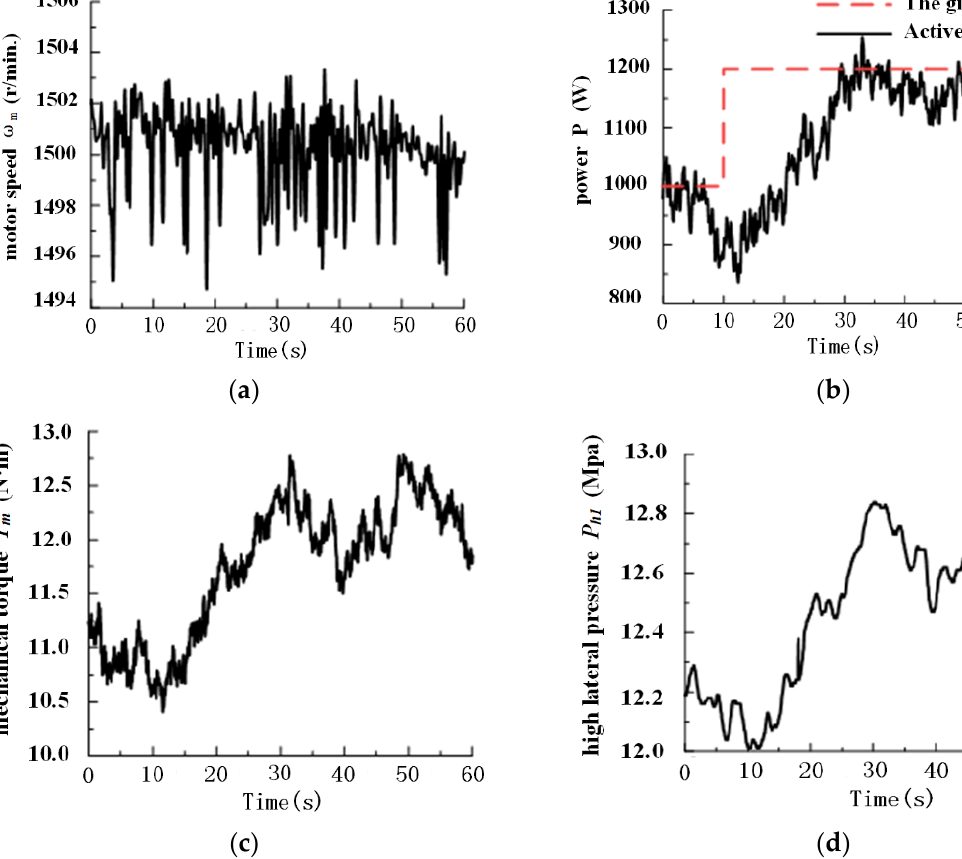
Figure 23. Unit power control experiment curve. ( a ) Motor speed curve. ( b ) Unit power control curve. ( c ) Generator drive torque curve. ( d ) Transmission system high-pressure